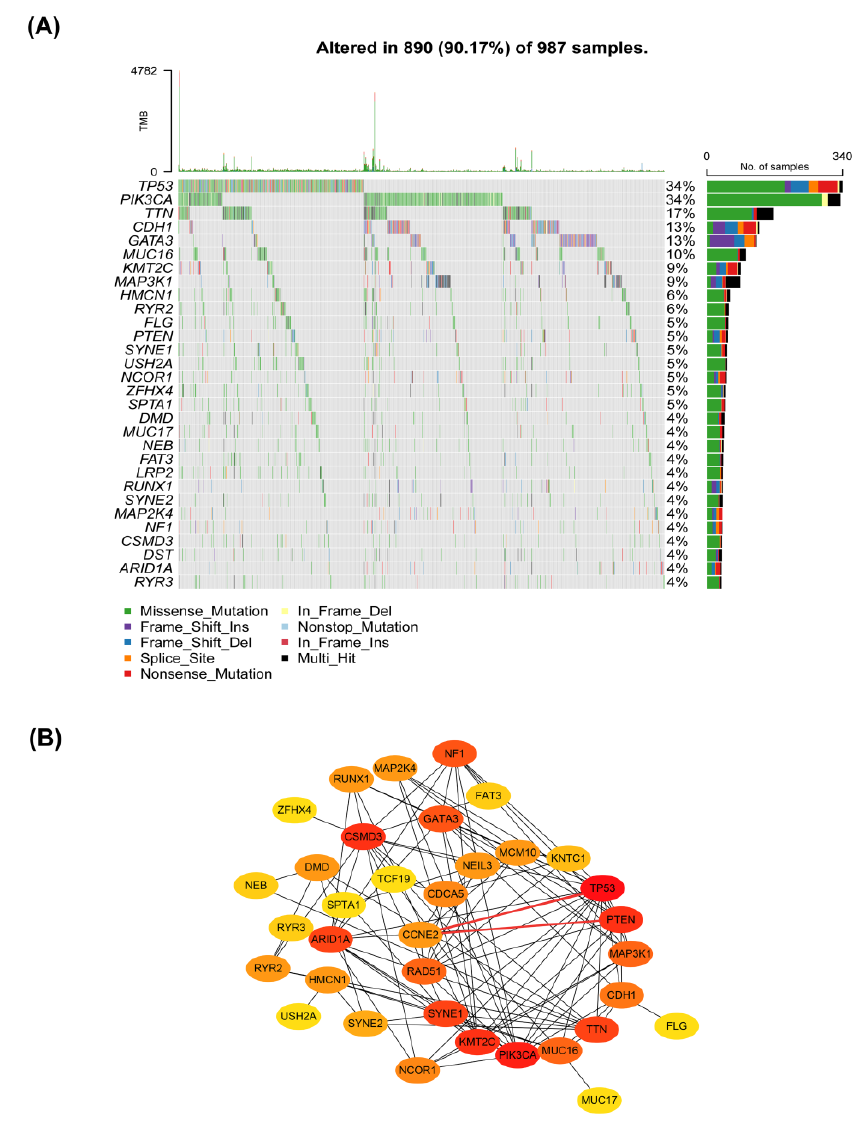
Figure 9. Protein–protein interactions between seven candidate genes ( CCNE2, CDCA5, RAD51, TCF19, KNTC1, MCM10, and NEIL3 ) and the top 30 most frequently mutated genes in the TCGA- BRCA. ( A ) The waterfall plot of mutation profiles of the top 30 most frequently mutated genes in 987 BRCA samples. ( B ) Interactions between seven candidate genes ( CCNE2, CDCA5, RAD51, TCF19, KNTC1, MCM10, and NEIL3 ) and the top most frequently mutated genes.